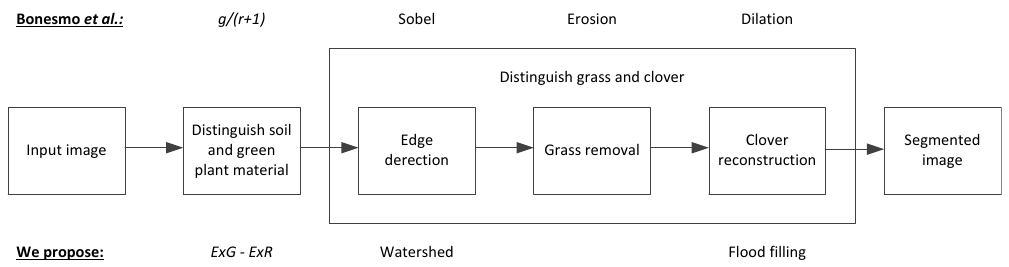
Figure 3. Overview of the image segmentation method and proposed improvements. The block diagram shows the steps involved in the soil-clover-grass segmentation of the image. Above each block, the method used by Bonesmo et al. [6] is shown. Below each block, our proposed alternatives are shown. To distinguishing between soil and green plant material, Bonesmo et al. [6] used the ratio between green and red ( g / ( r + 1 ) ), where we propose to use the difference between excess green and excess red ( ExG − ExR ). Next, grass and clover are distinguished in three steps. In the first step, edges are detected. Bonesmo et al. [6] thresholded a gradient image derived from the Sobel operator to detect edges. We propose using the watershed algorithm to derive the edges from the gradient image. In the second step, grass is removed by morphologically eroding the inverted edge image. In the third step, clover is reconstructed. Here, Bonesmo et al. [6] used morphological dilation. We propose using flood filling of the inverted edge image to reconstruct the clover leaves. All pixels not reconstructed are regarded as grass.